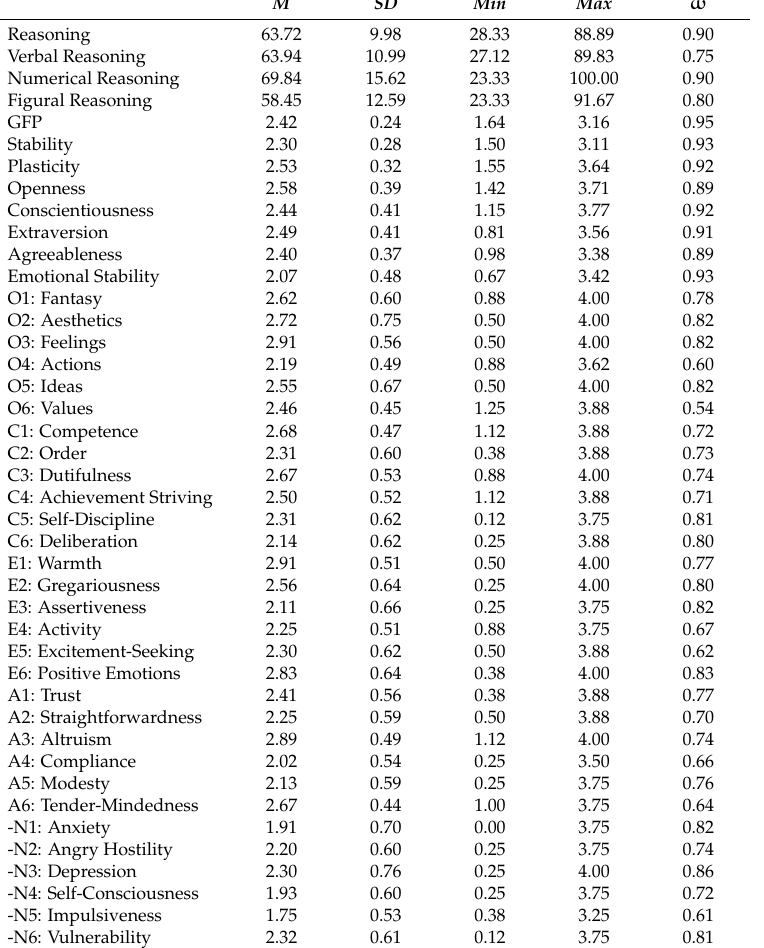
Table 1. Study 1: Descriptive statistics and reliability (McDonald’s Omega) ( N = 682). M SD Min Max